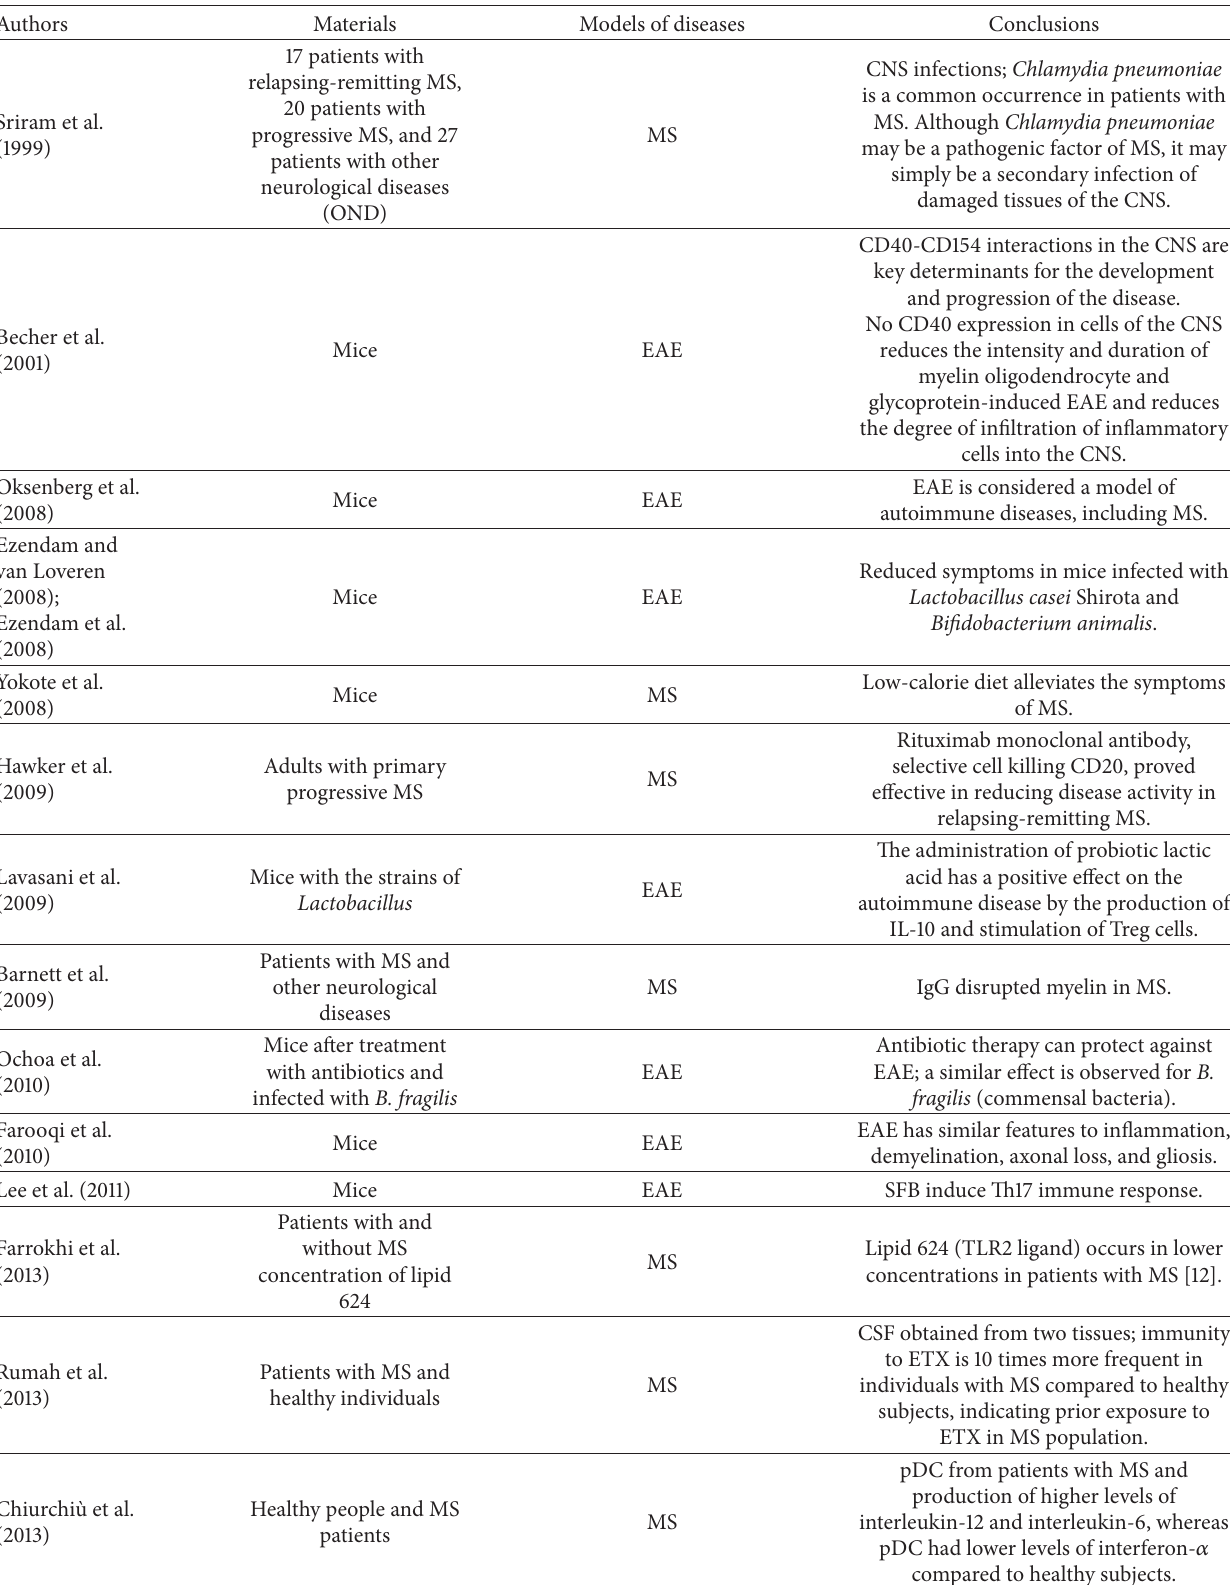
Table 2: Effect of gut microflora on the immune system in